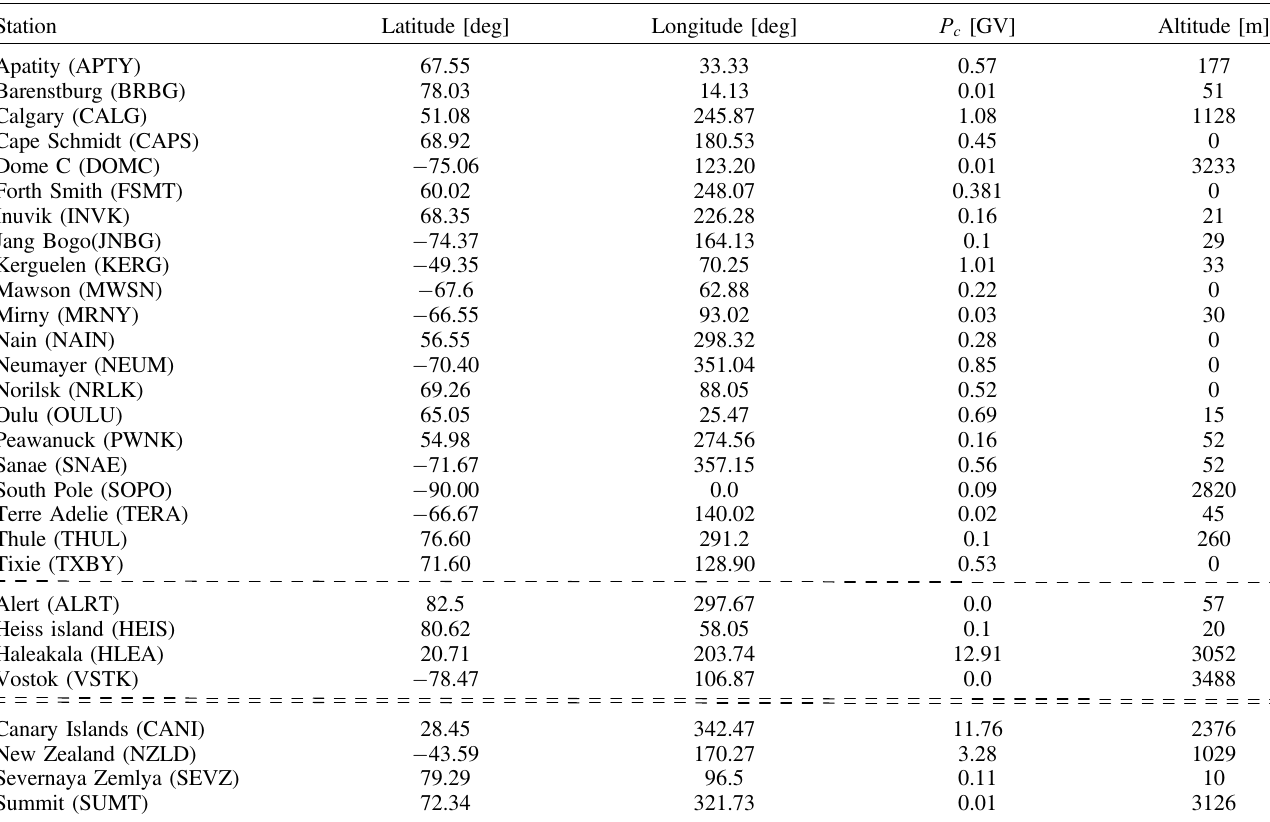
Fig. 2. Asymptotic directions of polar NMs. The abbreviations are given in Table 1. The color lines depict asymptotic directions plotted in the rigidity range 1 – 5 GV, for DOMC, SOPO, SUMT and VSTK from 0.7 to 5 GV respectively. The dashed lines correspond to new NMs proposed for extension of the network or to be reopened. The lines of equal pitch angles relative to the anisotropy axis of example event are plotted for 15 (cid:3) and 30 (cid:3) for sunward direction. The fi gure is adapted from Mishev et al. Table 1. Neutron monitors used in this study. Columns represent station name, location, geomagnetic cut-off rigidity and altitude above sea level. The table encompasses the current status of low rigidity stations (the part above the dashed line), the closed but previously existing stations to be reopened (the part between the dashed and dashed-dashed lines) and new stations proposed to extend the network (the bottom part).